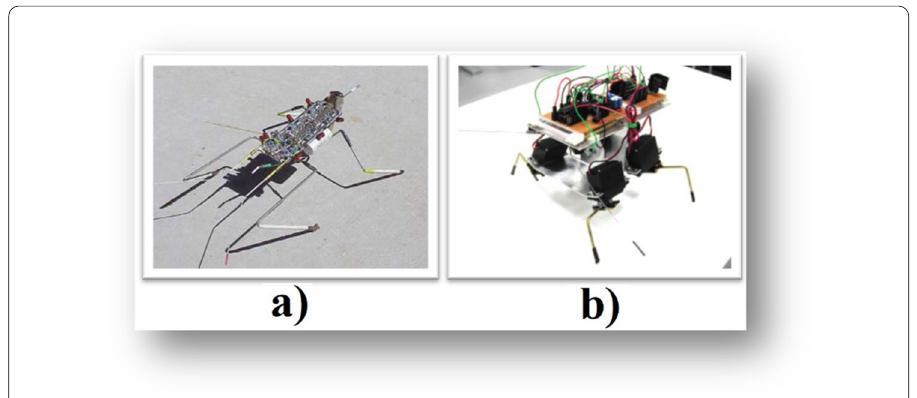
Fig. 1 a BEAM robot with an insect‑like shape (Rietman et al., 2003), b A BEAM robot, called QUL 1.4 (Vadakkepat et al., 2012)